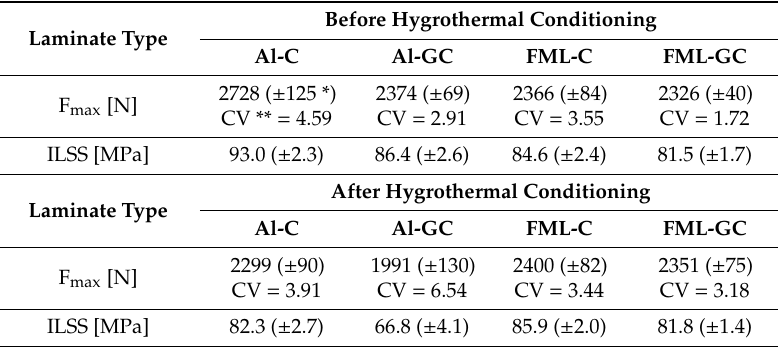
Table 1. Interlaminar shear strength values for tested